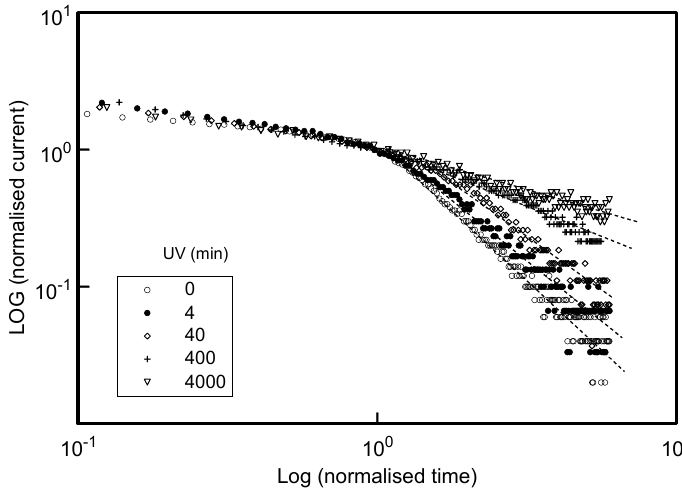
Figure 7. TOF current-time signals recorded at V = 250 V for a series of DEH MDP films that have been subjected to the UV exposure periods indicated. The signals have been normalised to the observed hole transit-times, and corresponding currents at these transit-times, to facilitate shape comparisons. The dashed lines are an aid for the eye in the post transit-time